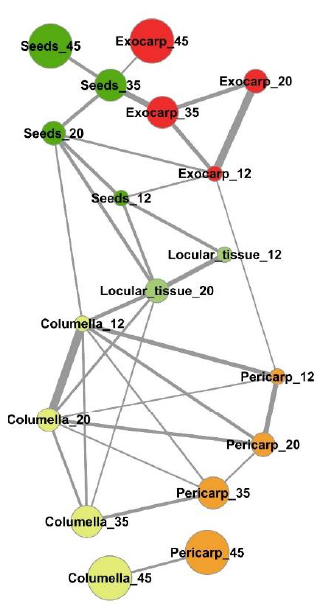
Figure 5. Mapping of compositional distances between sample means per tomato fruit tissue and stage of development based on the absolute contents in 39 metabolites and starch. Euclidian distances (edges) calculated using mean centered and unit-variance scaled data of five tissues at four stages of development (nodes). Only sample mean pairs with distances lower than 0.5 are mapped. All distances are indicated in Figure S2. Exocarp in red, Mesocarp with endocarp in orange, Columella with placenta in yellow, Locular tissue in light green, Seeds in dark green. The node size is proportional to the fruit stage of development. The edge width is inversely proportional to the distance value.